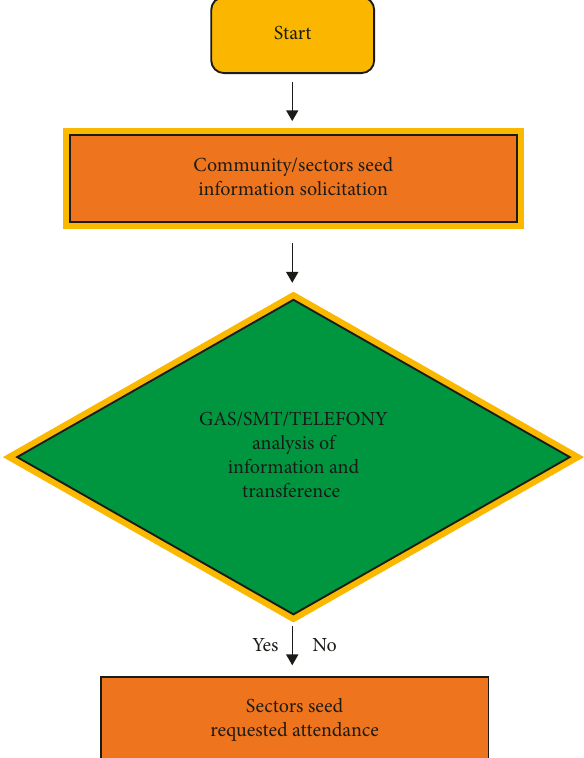
Figure 12: Flowchart drawing of case